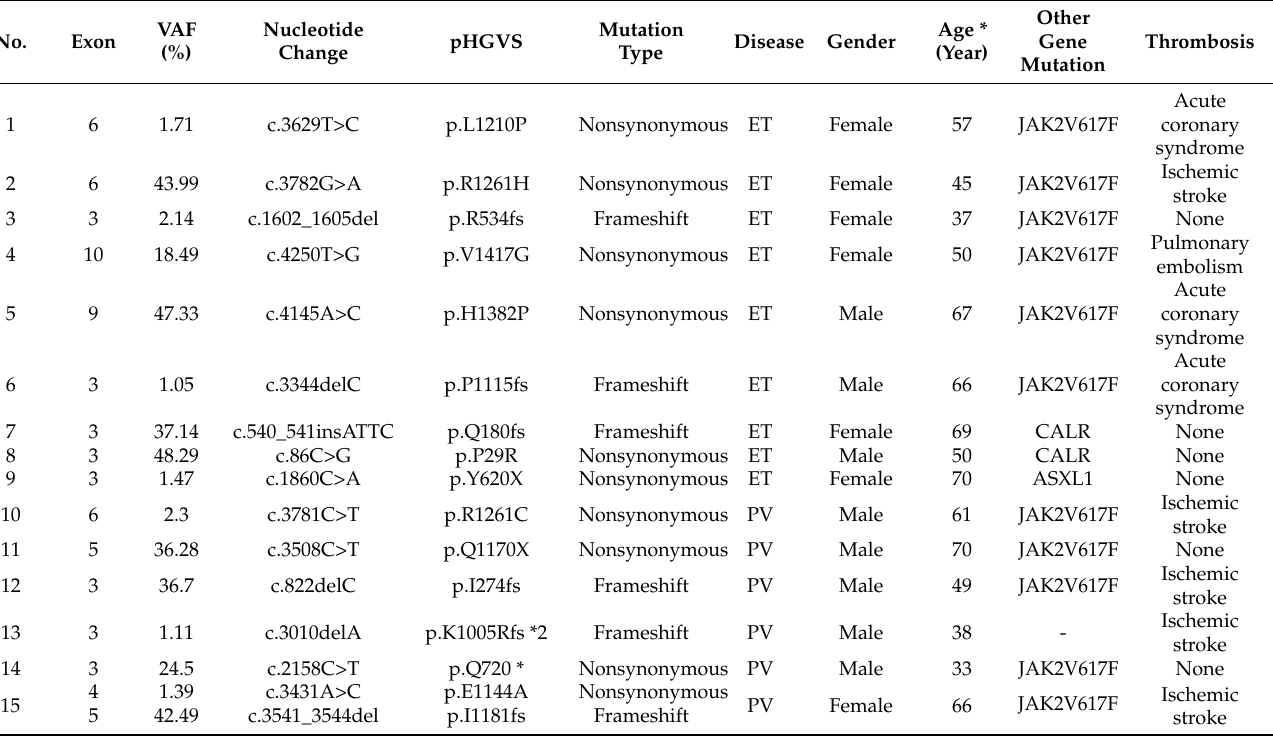
Table 4. TET2 mutation information in 15 MPN patients.